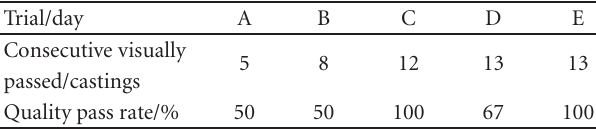
Table 3: X-ray and pressure test quality control sample of consecu- tive visually passed castings achieved on the di ff erent days with the CSIR-RCS and HPDC. X-rayed brake calipers were solution heat- treated at 540 ◦ C for 1 hour and quenched. Pressure tested brake calipers were peak aged by solution heat treatment at 540 ◦ C for 1 hour, quenched and artificially aged at 180 ◦ C for 4 hours. A B C D E Trial/day /castings X-rayed test Pressure test Total tested Pass X-ray test Pass pressure test Total passed Sample pass rate/% Table 4: Stability and quality summery table for brake caliper casting trials over five days with the CSIR-RCS-HPDC process cell. Trial/day A B C D E Consecutive visually 5 8 12 13 13 passed/castings Quality pass rate/% 50 50 100 67